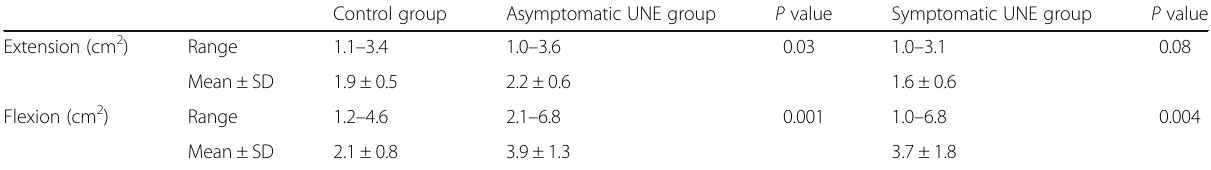
Table 2 The ulnar nerve flattening ratio in the asymptomatic ulnar nerve entrapment (UNE) group and the symptomatic UNE group compared to the control